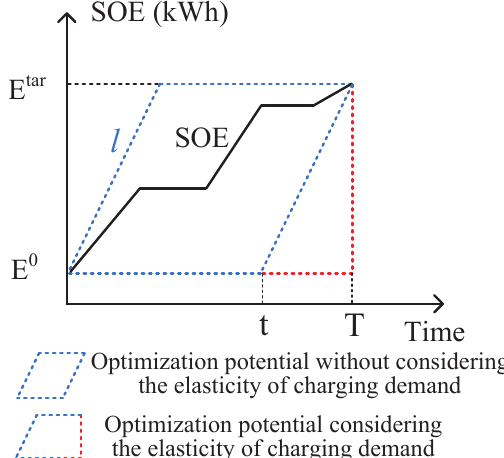
Figure 3. Potential for optimization with or without considering the elasticity of charging